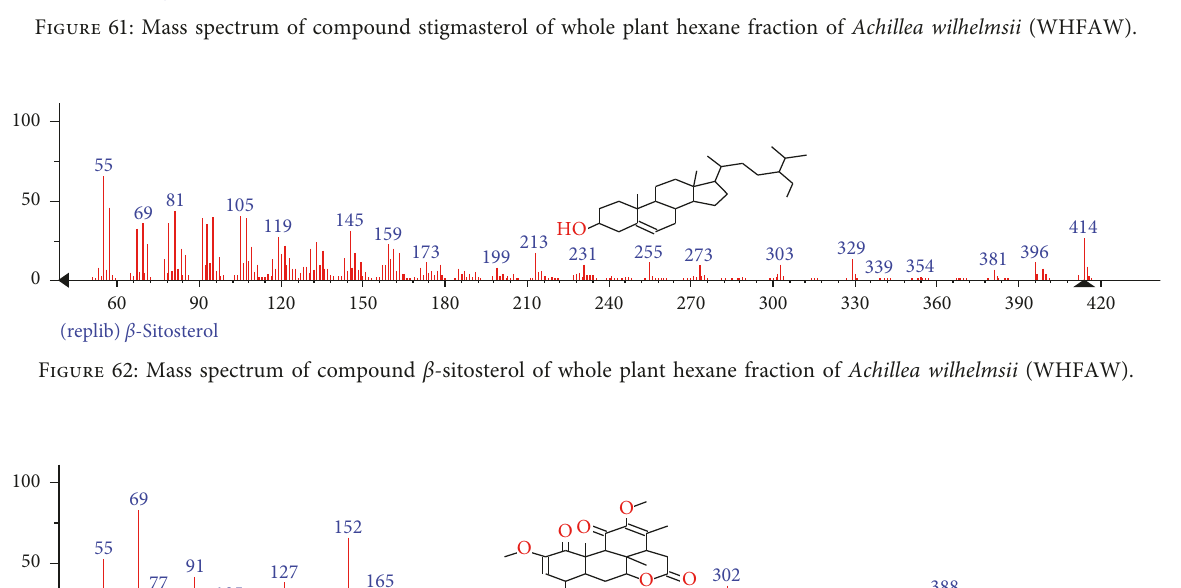
Stigmasterol60 80 (mainlib) Figure 61: Mass spectrum of compound stigmasterol of whole plant hexane fraction of Achillea wilhelmsii (WHFAW).